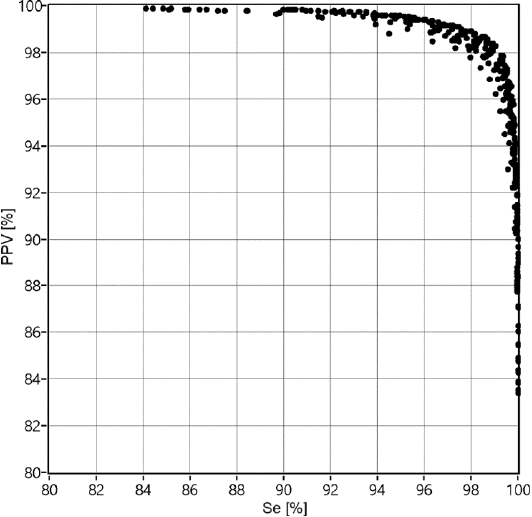
Figure 5. The values of Se and PPV obtained for 361 combinations of the applied validation criteria: window width w = {10, 20,…,190} and percentage threshold p = {5, 10,…, 95}.